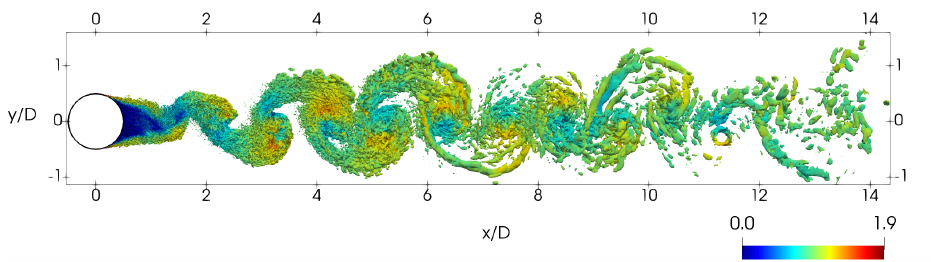
Figure 1. Vortical structures identified by means of Q iso-contours colored by the velocity